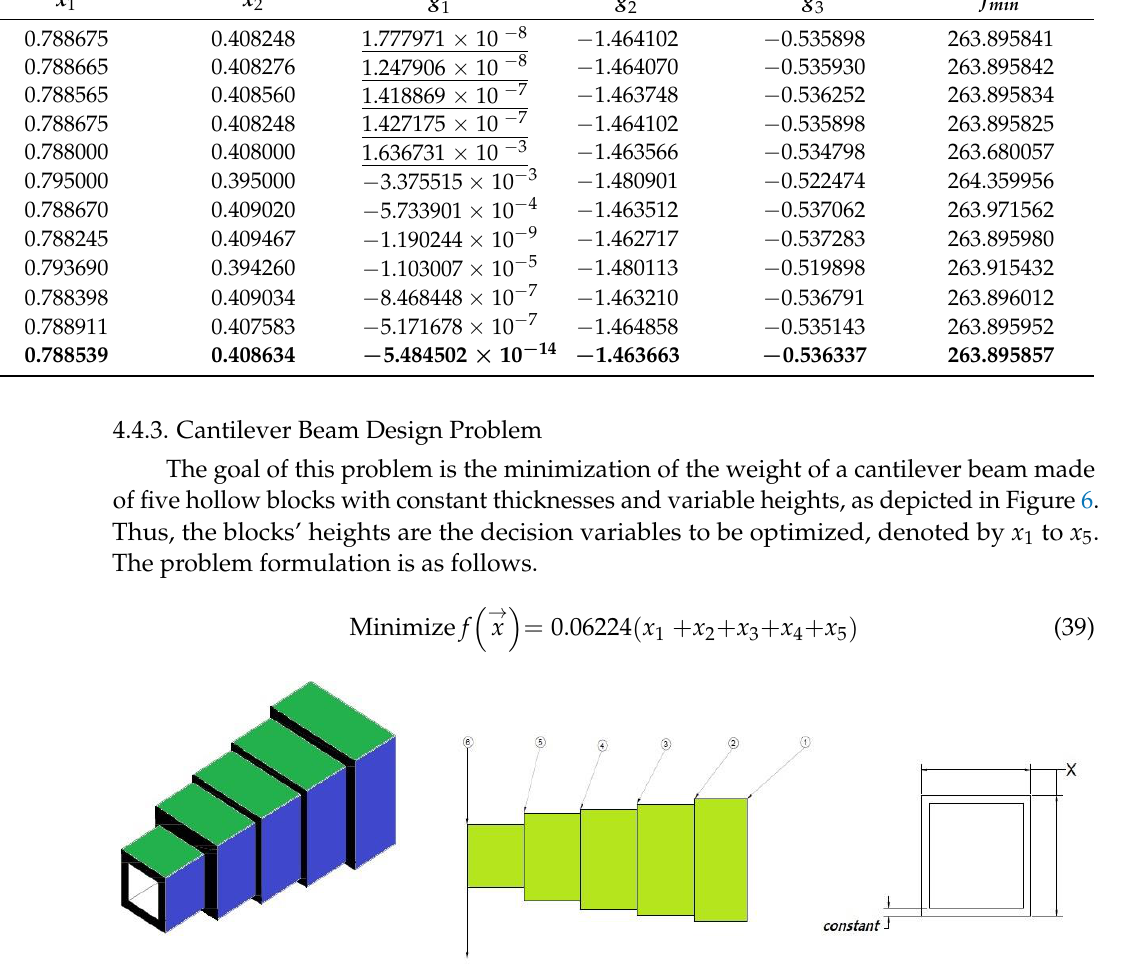
Figure 6. Cantilever beam problem [44]. “Reprinted from Publication Reptile Search Algorithm (RSA): A nature-inspired meta-heuristic optimizer, vol. 191, 1–32, Copyright (2022), with permission from Else- vier."